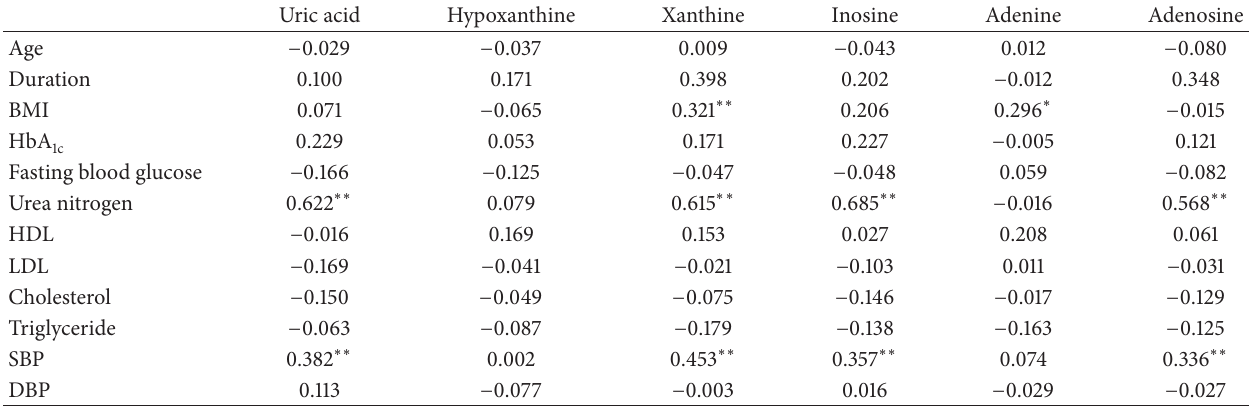
Table 3: Correlations between six purine metabolites and clinical parameters.